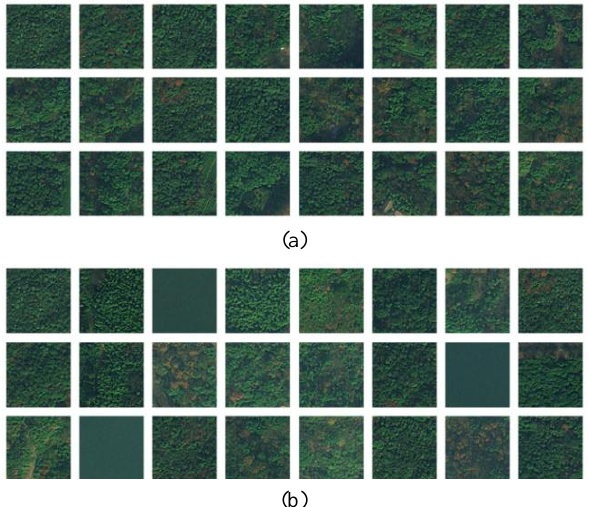
Figure 4. Forest retrieval results for WorldView-2 image